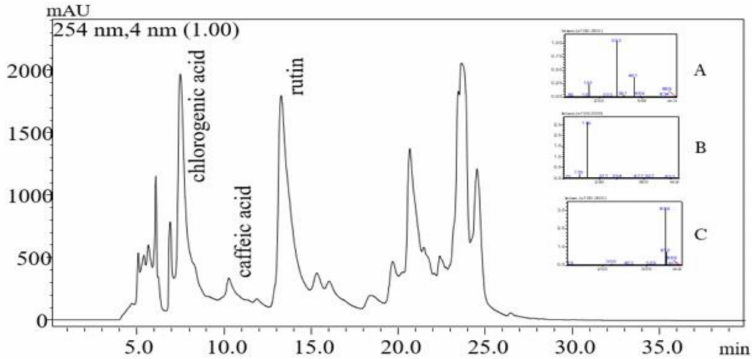
Figure 1. HPLC chromatogram of the extract from Solidago virgaurea L. and mass spectra of chloro- genic acid ( A ), caffeic acid ( B ), and rutin ( C